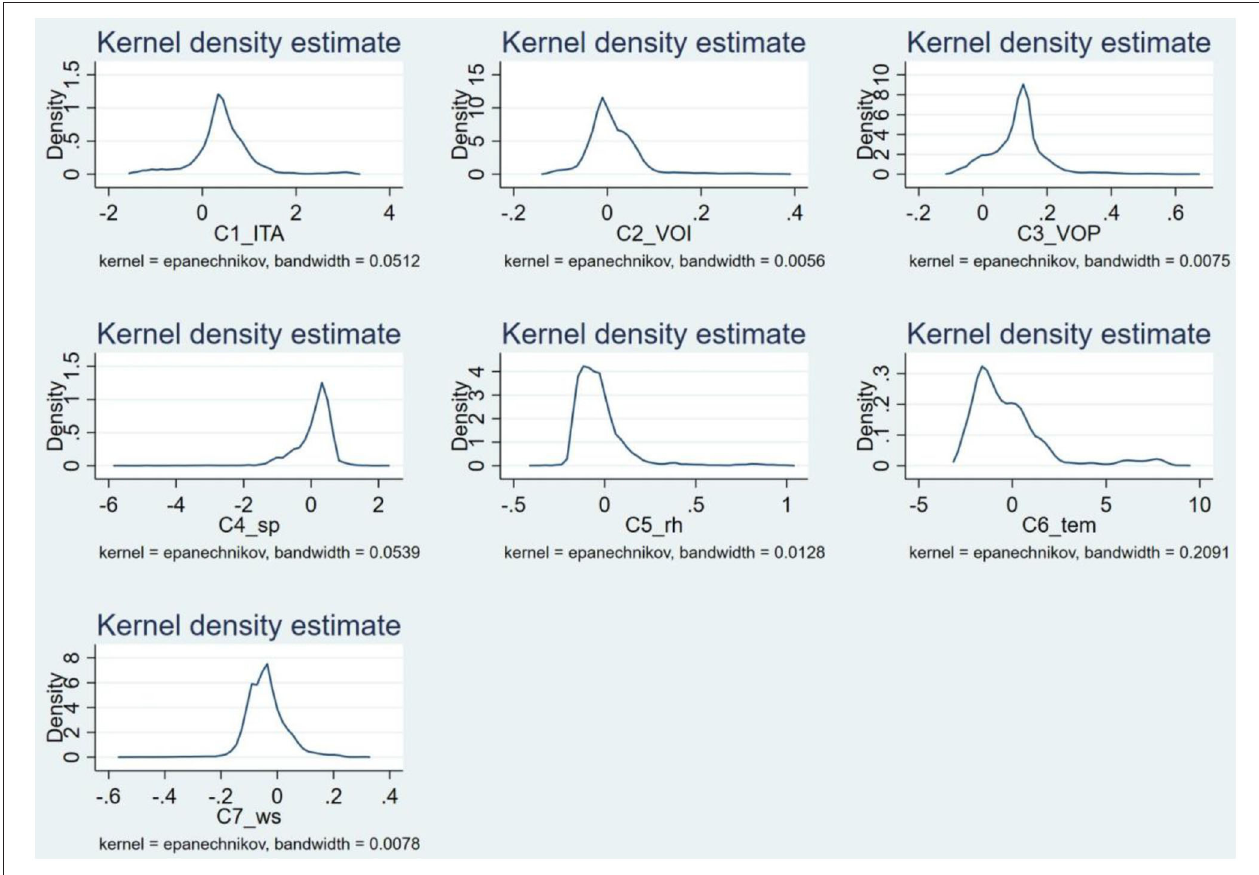
FIGURE 4 | Kernel density distribution of each variable